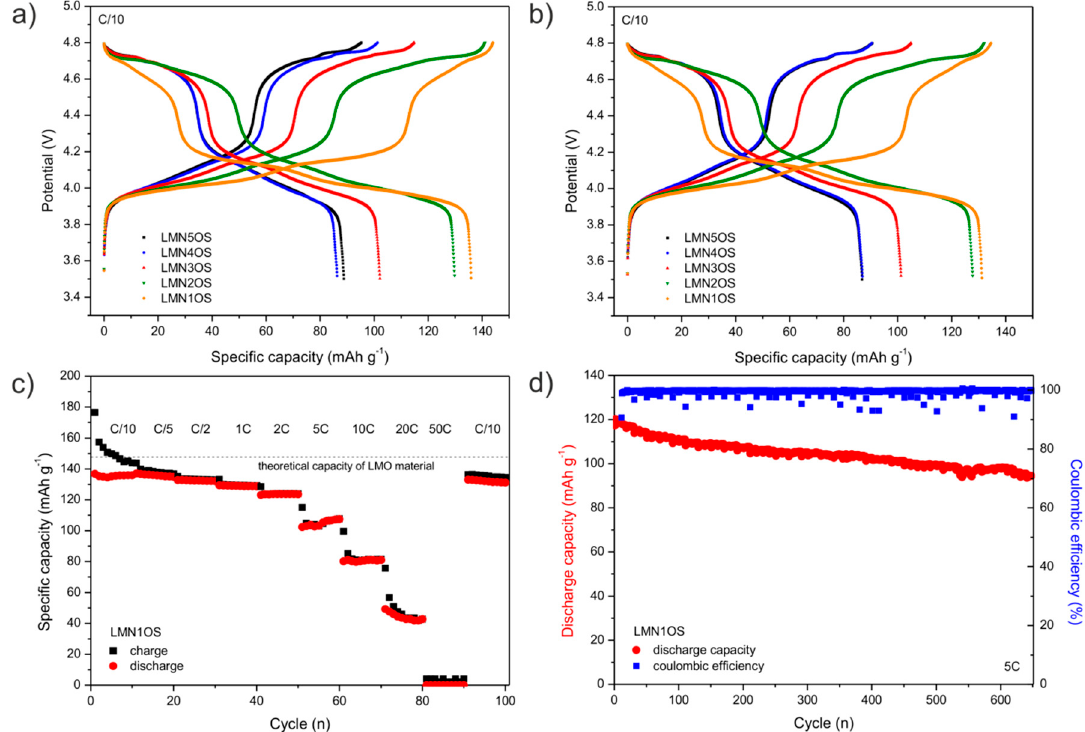
Figure 6. Galvanostatic charge-discharge voltage profiles for ( a ) the tenth; and ( b ) hundredth cycle of the LMNOS cathode materials at C /10 current rate; and ( c ) change in specific charge-discharge capacity as a function of cycle at various C rates; and ( d ) long cycling performance at 5 C of LMN1OS